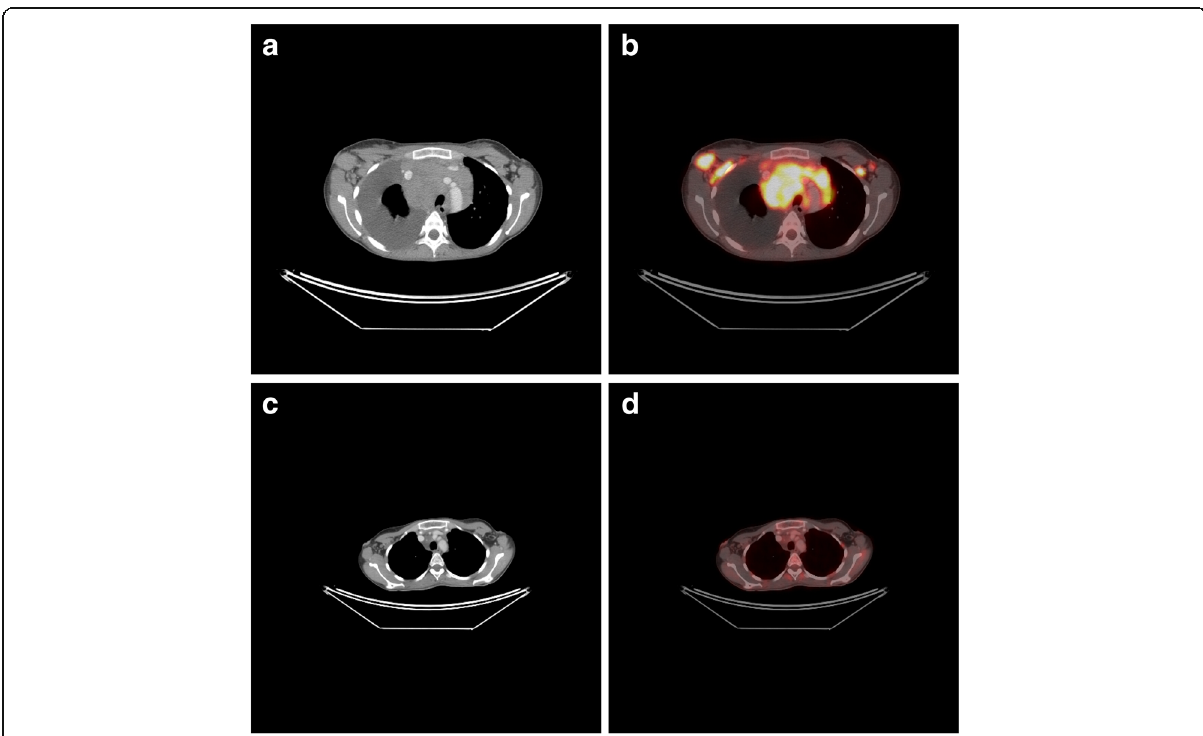
Fig. 6 A 19-year-old female patient, known case of HL. Pre-treatment PET-CT images ( a , b ) show multiple amalgamated hypermetabolic FDG avid lymph nodes. PET CT images at follow-up ( c , d ) show marked regression of the size and the number of the lymph nodes; all of them show no metabolic activity. The patient was categorized as partial regression on CT and complete regression on